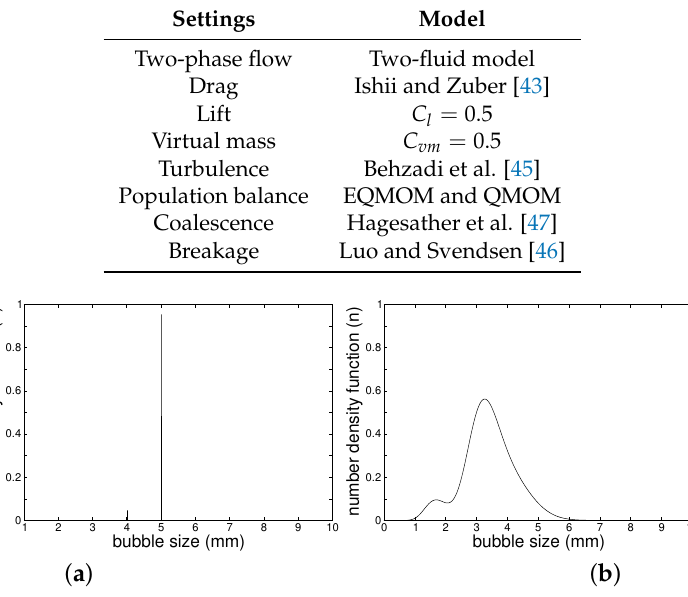
Figure 4. Number density function in water zone (liquid phase) using EQMOM ( a ) N α = 2 and ( b ) N α = 3.